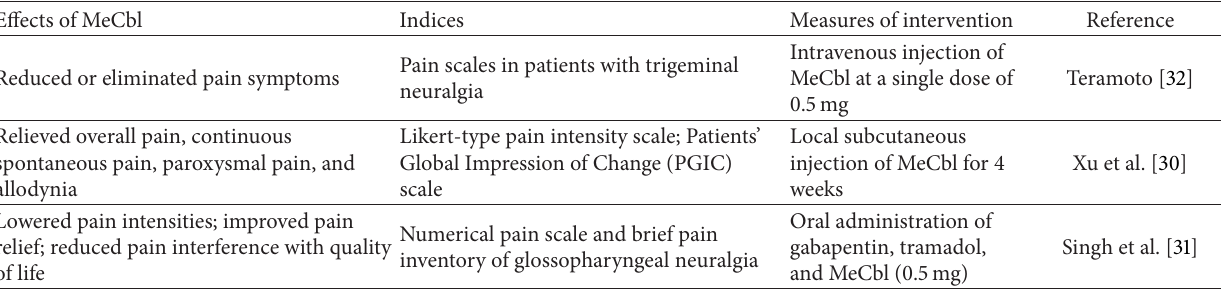
Table 3: The analgesic effect of MeCbl or combined with other agents on neuralgia. Effects of